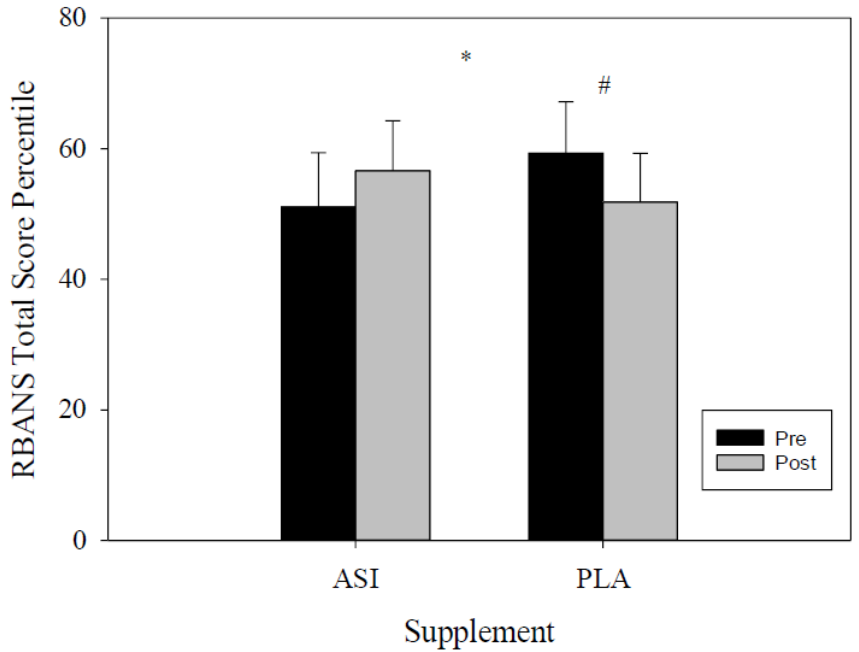
Figure 2. Total RBANS percentile score. * indicates differences between supplement ( p < 0.05); #—indicates differences within-trial.